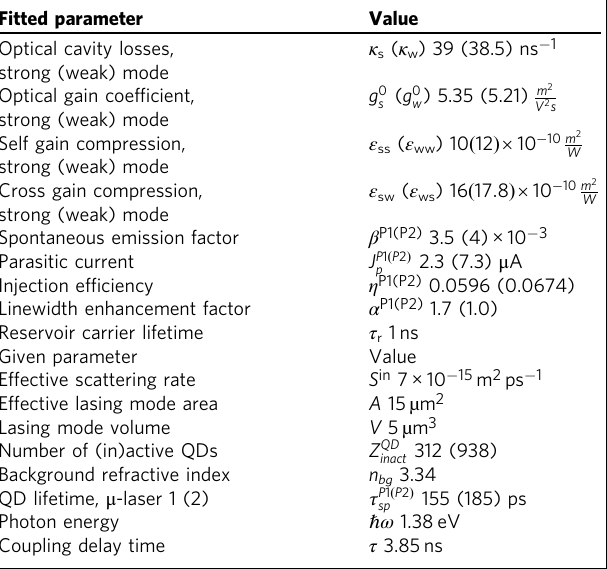
Table 1 Parameters used for the simulations if not stated otherwise Fitted